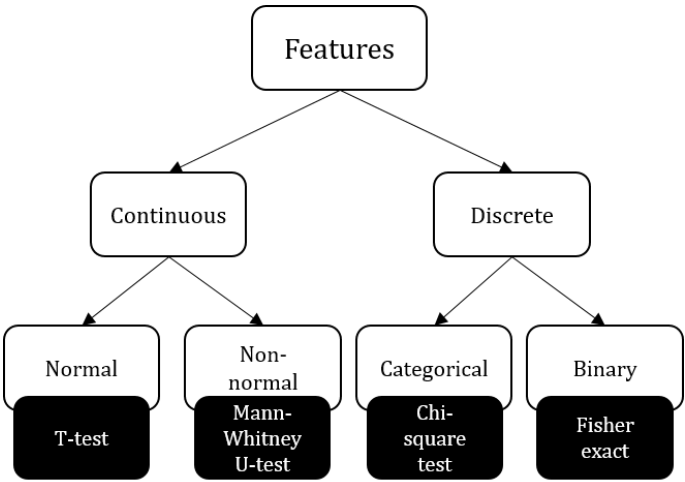
Figure 5. Statistical tests for each feature